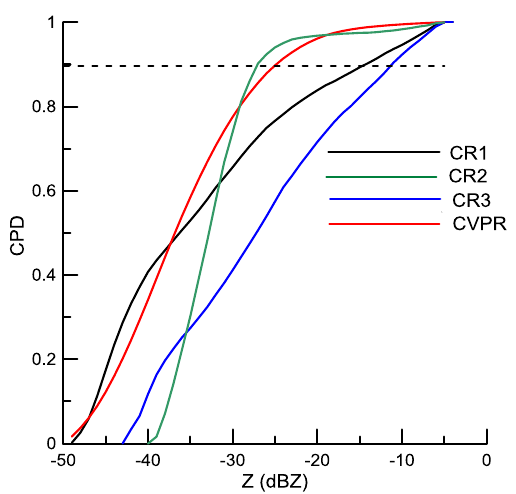
Figure 2. Cumulative probability distributions of “clear sky” reflectivity by CR1, CR2, CR3 and CVPR.